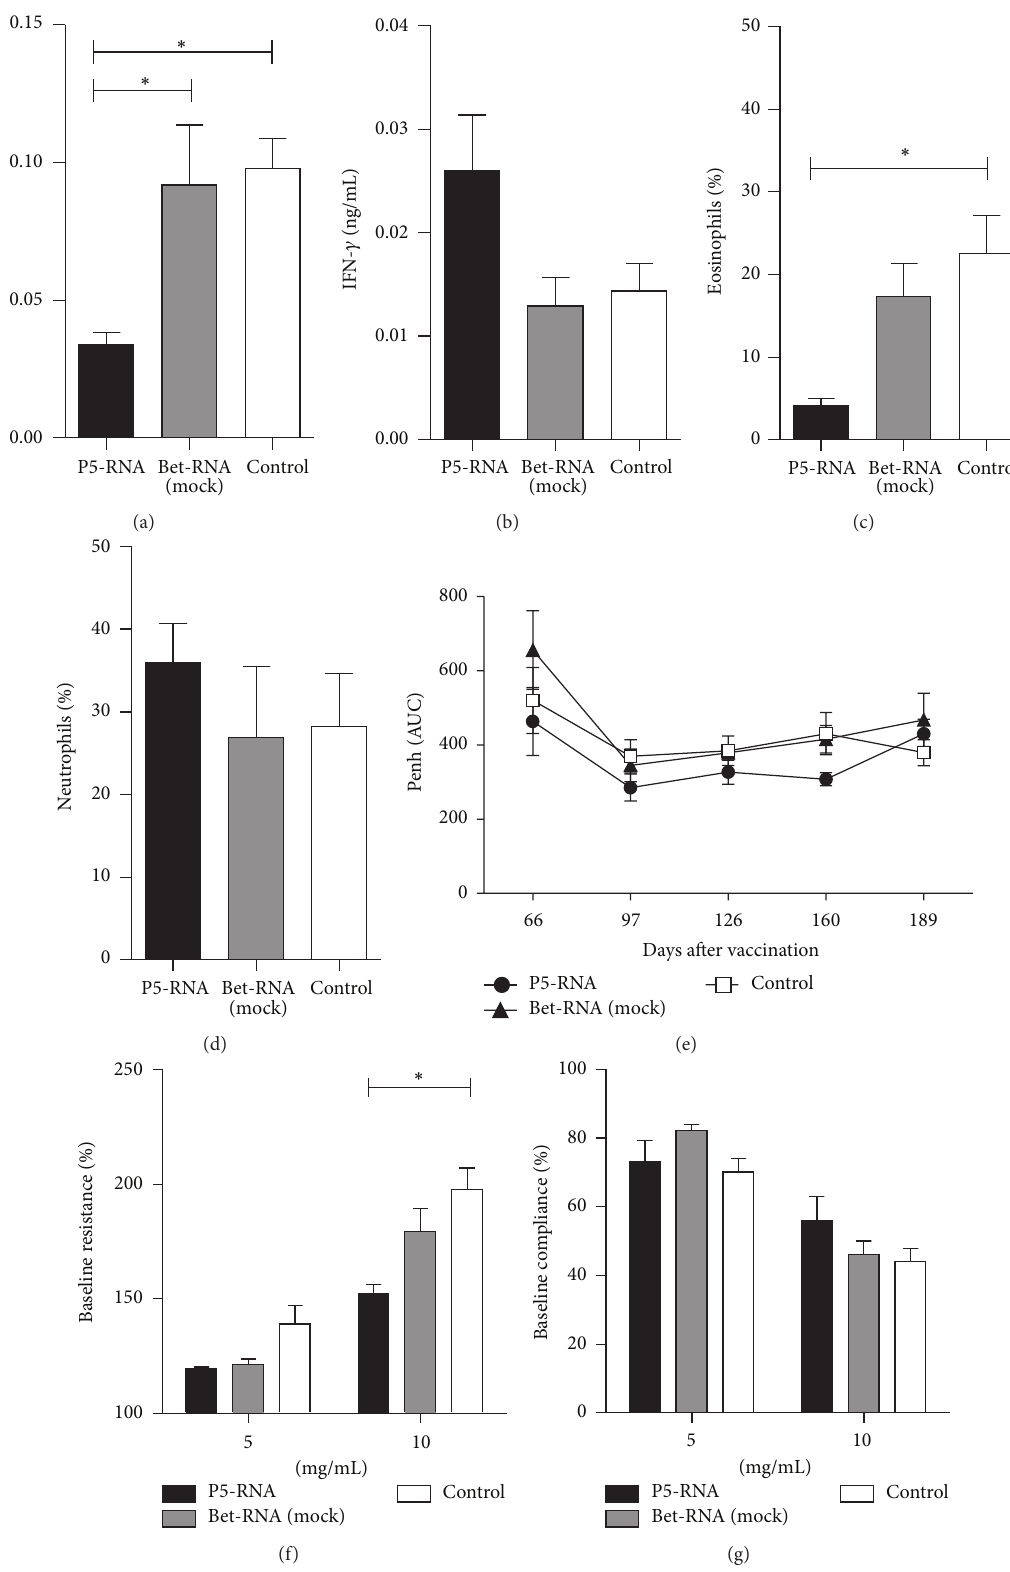
Figure 6: Levels of IL-5 (a) and IFN- 𝛾 (b) as well as the percentage of eosinophils (c) and neutrophils (d) of total leukocytes in BAL fluids determined 9 months after mRNA immunization. Effects of prevaccination on lung function were determined by measuring airway hyperresponsivenessvianoninvasivewhole-bodyplethysmographythroughouttheexperiment(e)orinvasivemeasurementoflungresistance (f) and dynamic compliance (g) at the endpoint. Mice were exposed to nebulized 0.9% NaCl followed by increasing concentrations of nebulized methacholine. Data are shown as means ± SEM ( 𝑛 = 5 ). ∗ 𝑝 < 0.05